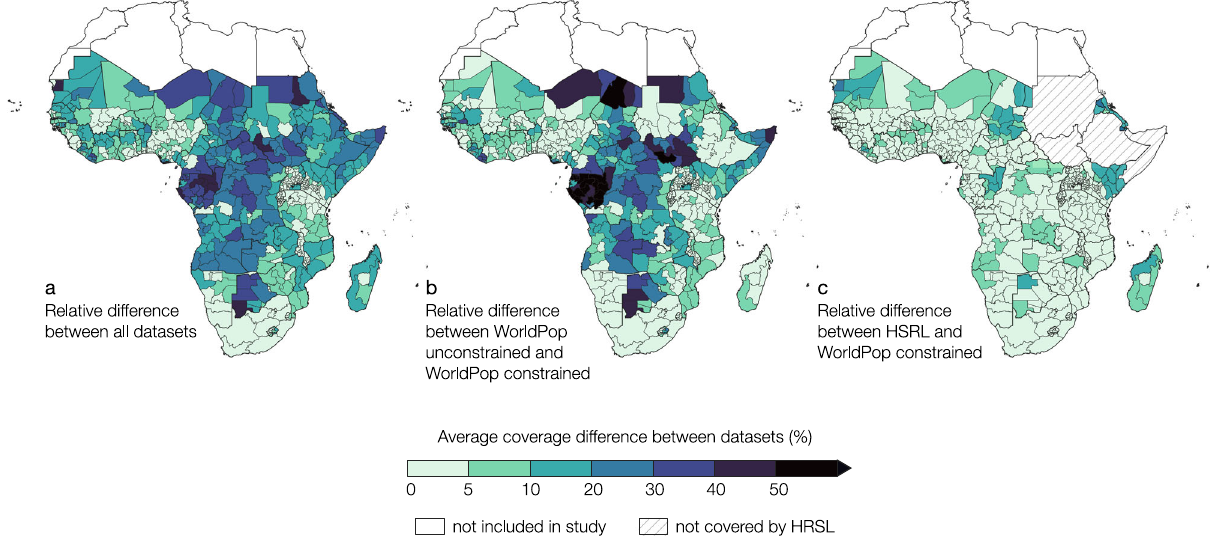
Fig. 5 Maps of relative difference in accessibility coverage estimates. Maps show the average relative difference in accessibility coverage statistics at 1-hour travel time between a all datasets, b WorldPop top – down unconstrained and WorldPop top – down constrained, and c HSRL and WorldPop top – down constrained for full sub-Saharan